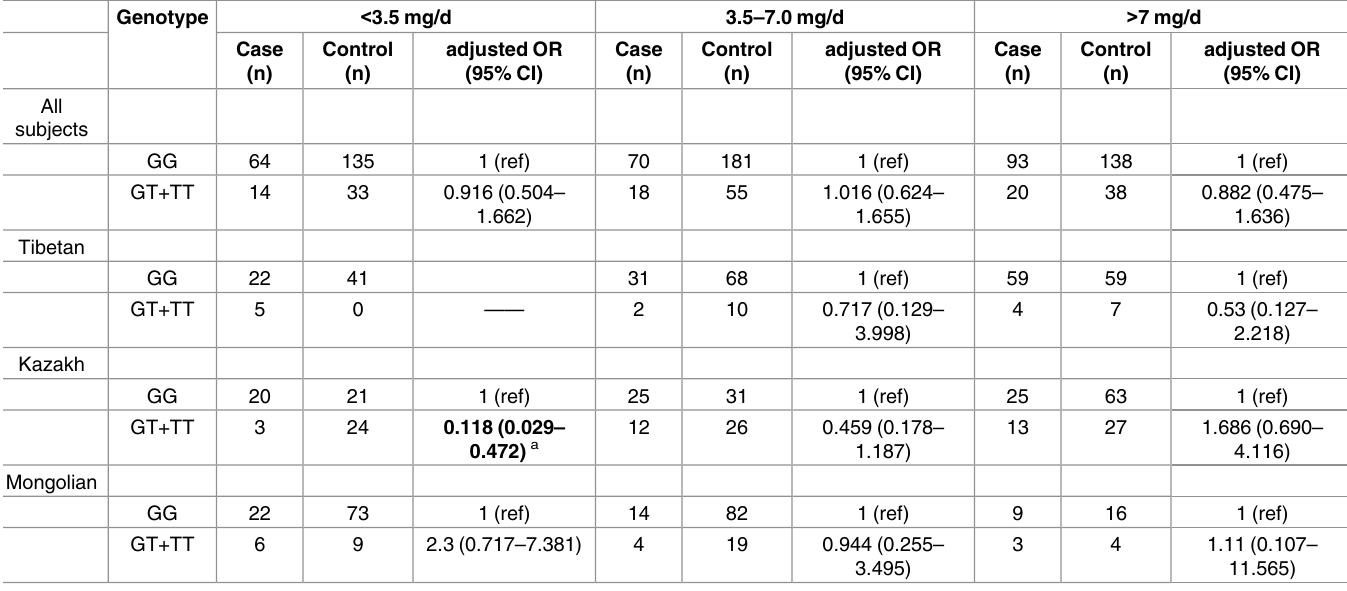
Table 6. Associations between skeletal fluorosis and the PRL rs1341239 genotype in different IF groups (overall or stratified by ethnicity).